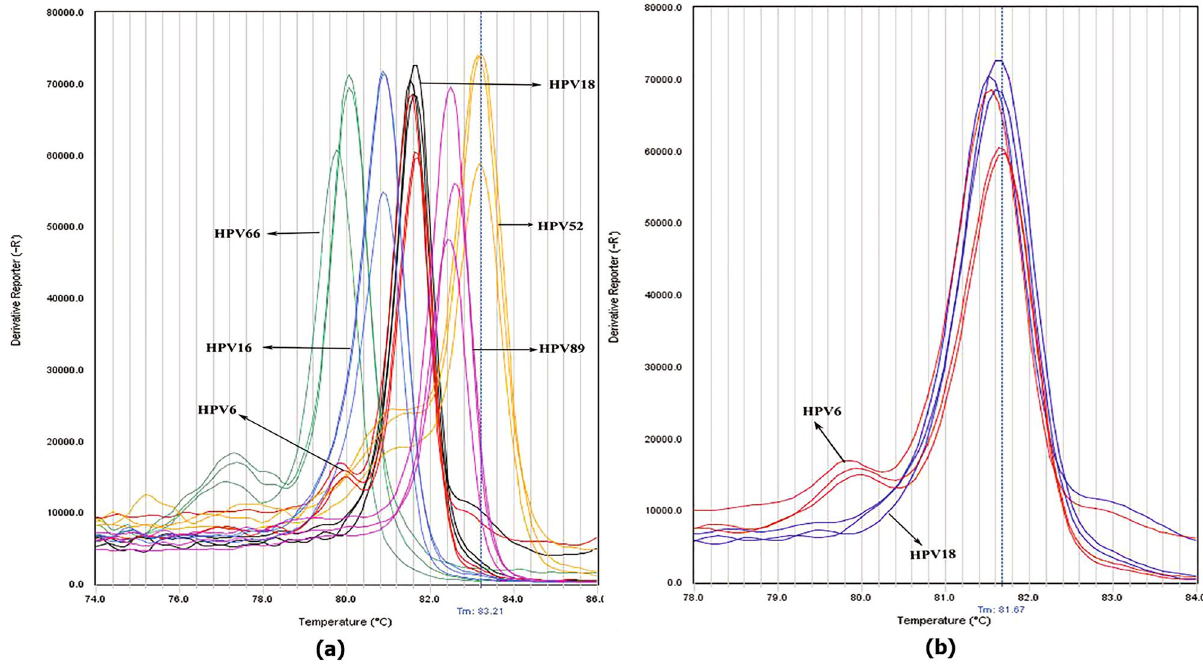
Figure 5. Melt curve of semi-nested qPCR-HRM reaction with FRG5, FRG2, and unlabeled probe U18 in approach three ( a ) related to diagnostic standard ( b ) HPV18 next to HPV6.